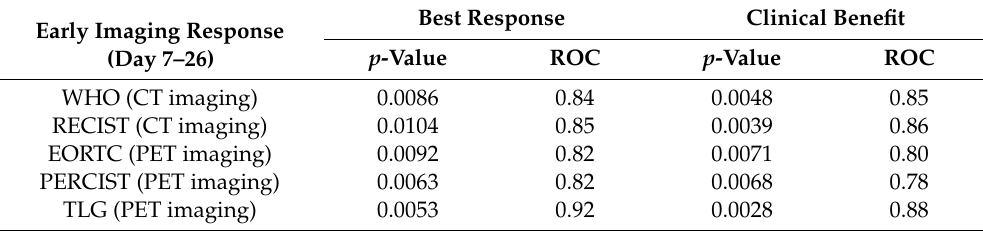
Table 2. Imaging-based measures of response predict tumor response and clinical benefit. Receiver operating characteristics (ROC) of CT and PET imaging are